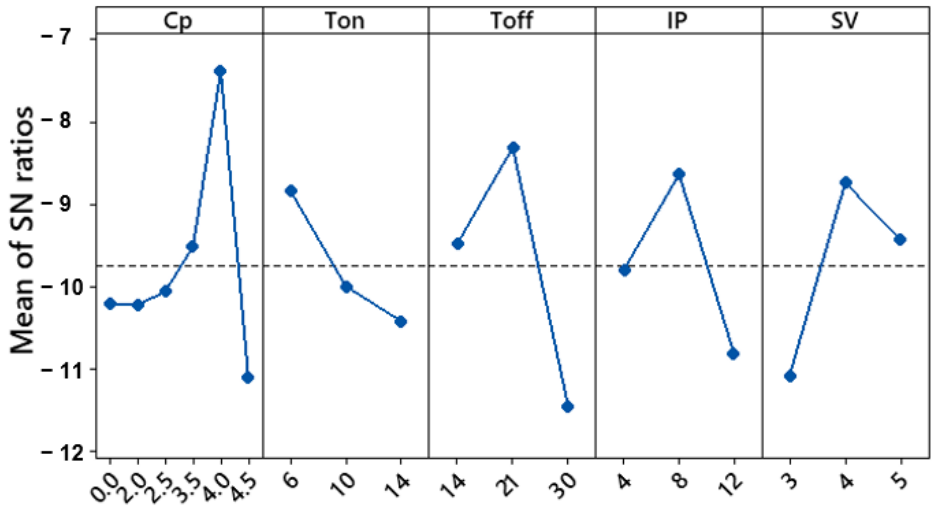
Figure 7. The S/N response analysis Figure 7. The S / N response